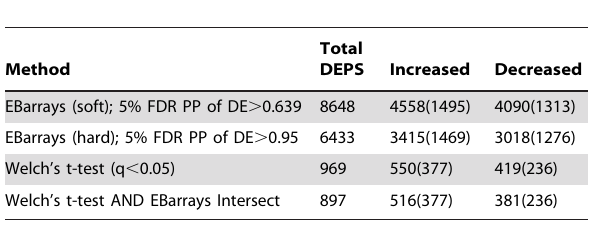
Table 1. Summary of Differentially Expressed Probe Sets